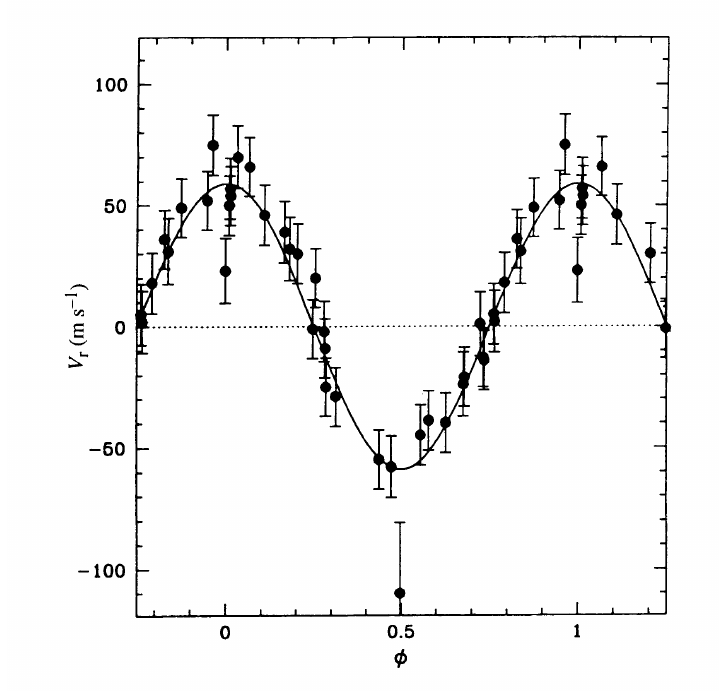
Figure 1. Figure showing the radial (line-of-sight) velocity of the star, 51 Pegasi, determined by measuring shifts in the star’s spectral lines. The periodic nature of the star’s radial velocity indicates the presence of a companion with a mass of about 0 : 4 Jupiter masses and an orbital period of only 4 : 2 days. (Figure from